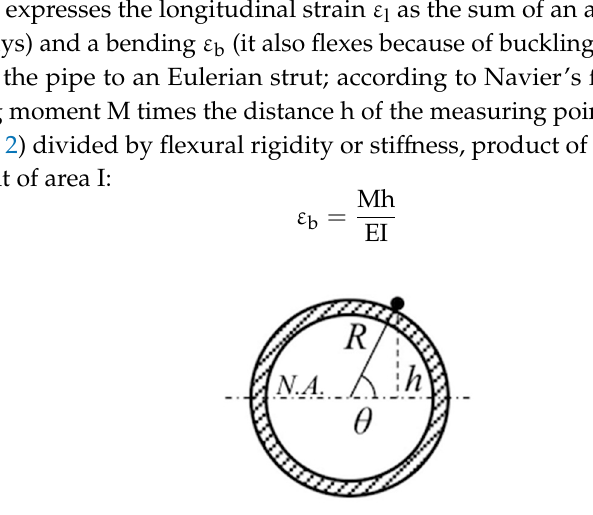
Figure 2. Schematic cross section of a pipe showing the main parameters of Equation (1): R, the outer radius; h, the distance from the neutral axis N.A.